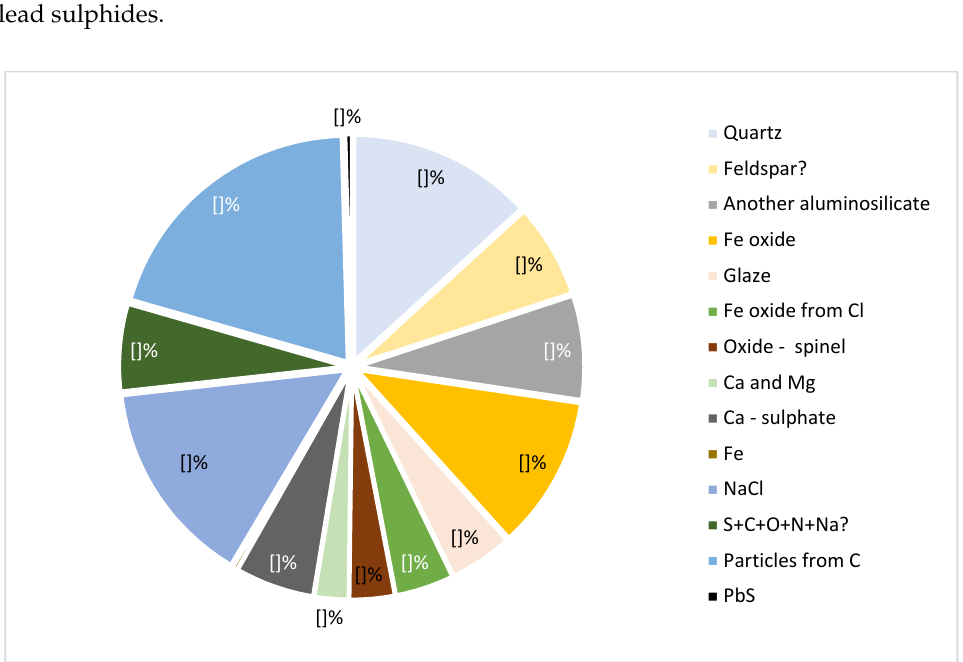
Figure 5. Surface area of grains (<10 µm) of different components of Pszczyna—Piasek dusts. Figure 6a–f presents the mineral composition of selected atmospheric dust particles.